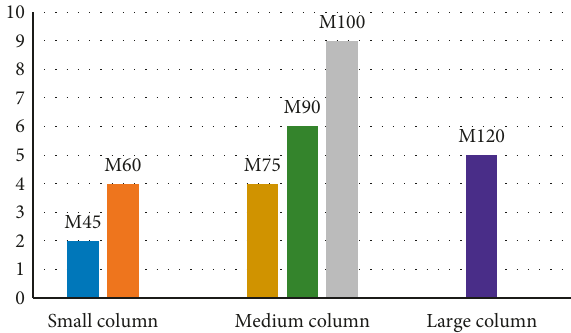
Figure 6: The test number of